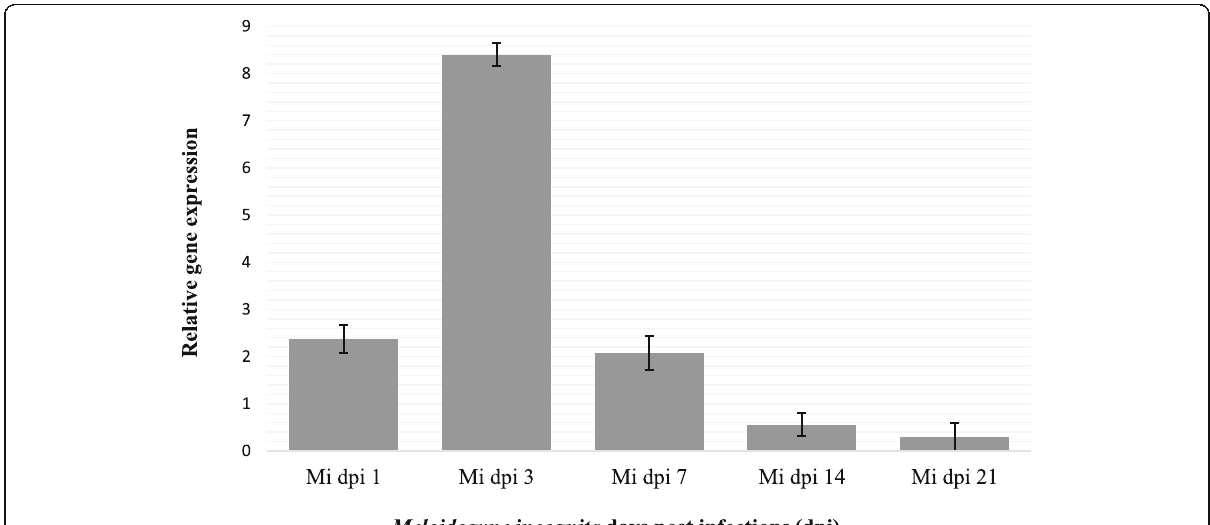
Fig. 2 Meloidogyne incognita induced proteinase inhibitor I gene expression in host tissues at different days post-infections. Housekeeping gene Actin gene was used to normalize expression of genes of interest. Relative gene expression was calculated biological replicates using the 2 △△ Ct method and uninfected (control) values were subtracted from infected values. Y axis represents relative gene expressions, X axis indicates 1 dpi, 3 dpi, 7 dpi, 14 dpi, and 21 dpi following Meloidogyne incognita infection. Error bars represents the standard error of the means of three replicates. Mi, Meloidogyne incognita ; dpi, days post